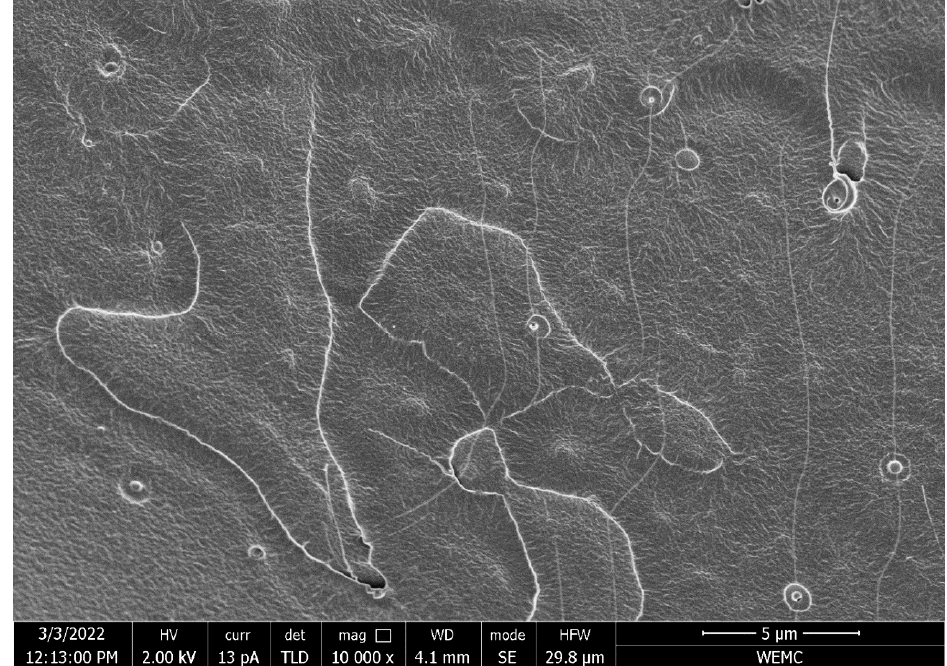
Figure A3. 13 C-NMR Spectra of (1) ChNC-C18:2, (2) ChNC-18:0, (3) ChNC-C12:0, (4) ChNC-C8:0, (5) ChNC-C4:0, and (6) Unmodified ChNC.